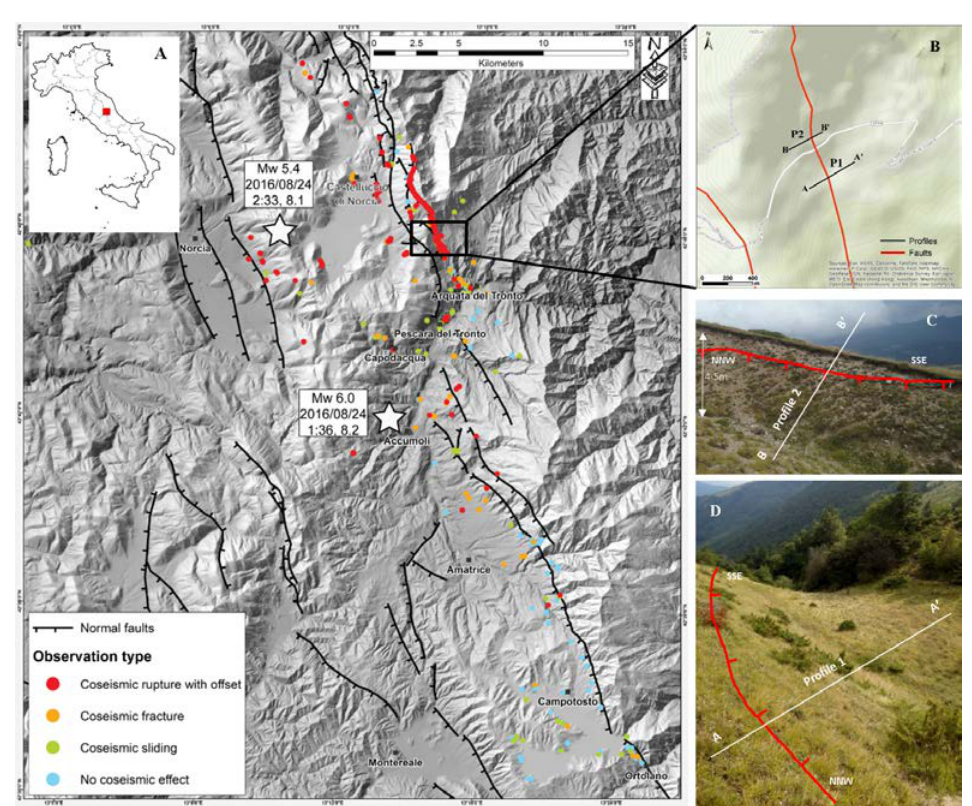
Figure 1. The figure shows: Digital Terrain Model of the area hit by the earthquake (ML=6.0) of 24 August 2016 that affected large part of the central Apennine between the municipalities of Norcia (PG) and Amatrice (RI) (Central Ita- ly), with different type of field recognised coseismic ruptures (A); the location of the soil gas profiles (B); photos of the investigated sites (C and